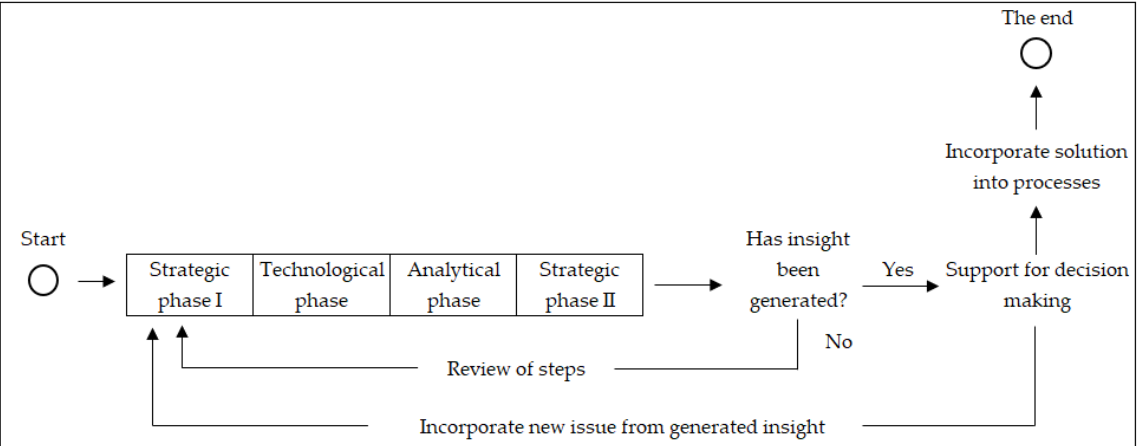
Figure 1. Framework for structuring a Big Data project.